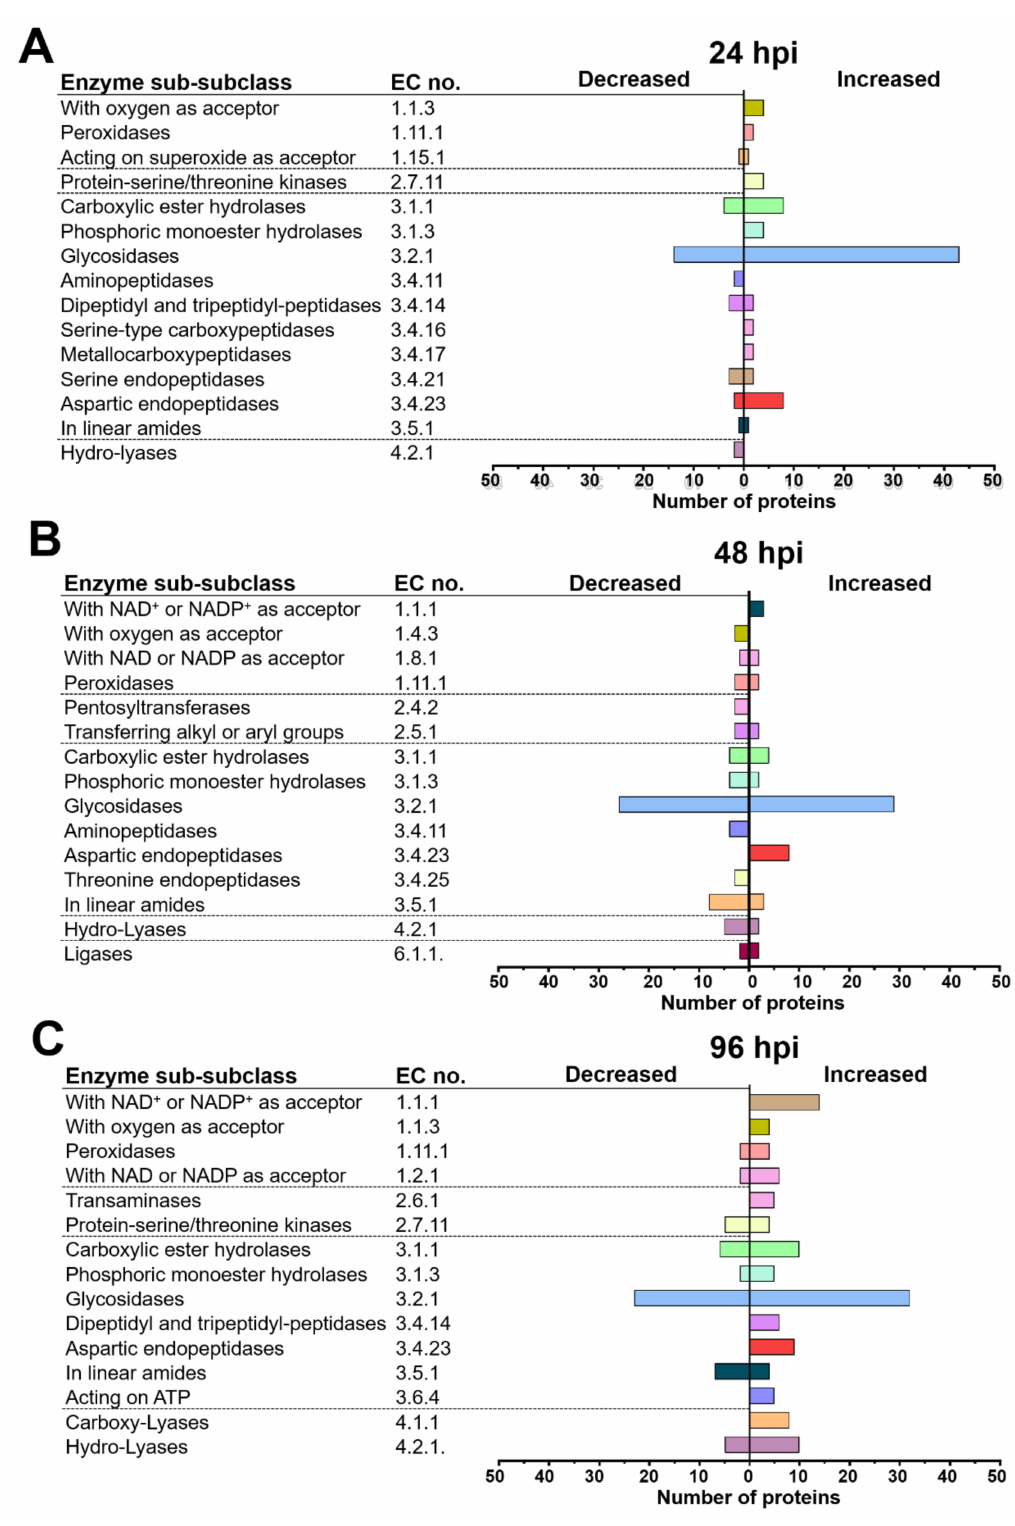
Figure 5. T. atroviride secreted mainly glycosidases and aspartic endopeptidases during its interaction with Arabidopsis . ( A ) Sub-subclasses of enzymes identified in the secretome of T. atroviride at 24 h, ( B ) 48 h, and ( C ) 96 h of interaction with Arabidopsis. The classification was based on the enzyme activity prediction using BRENDA